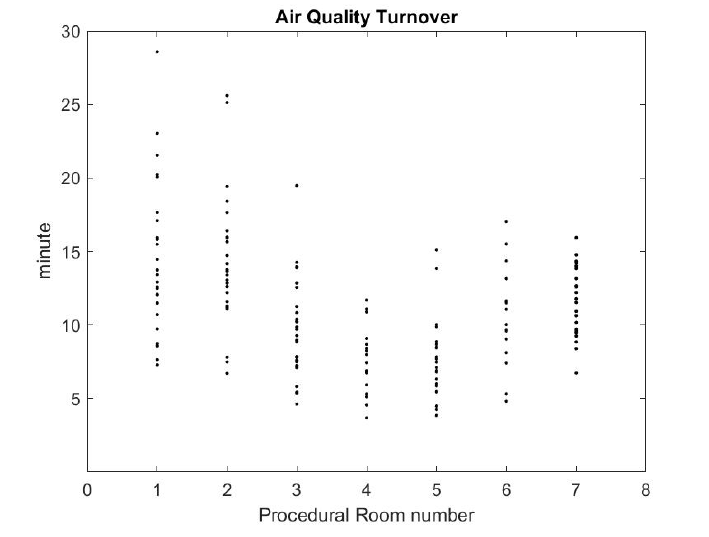
Figure 13. Air quality turnover time measured in clinical